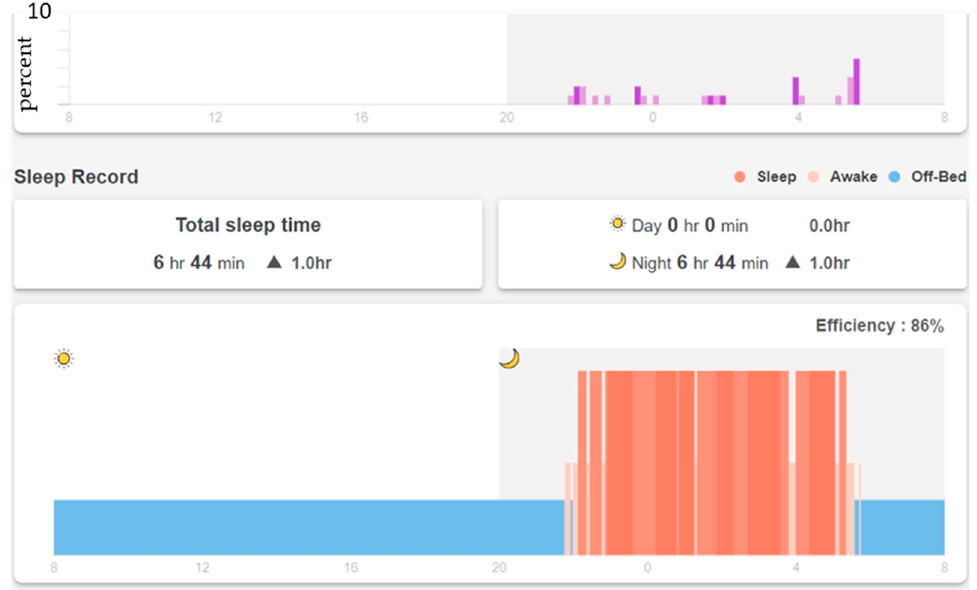
Figure 4. Movement counts and sleep record in 24 h.